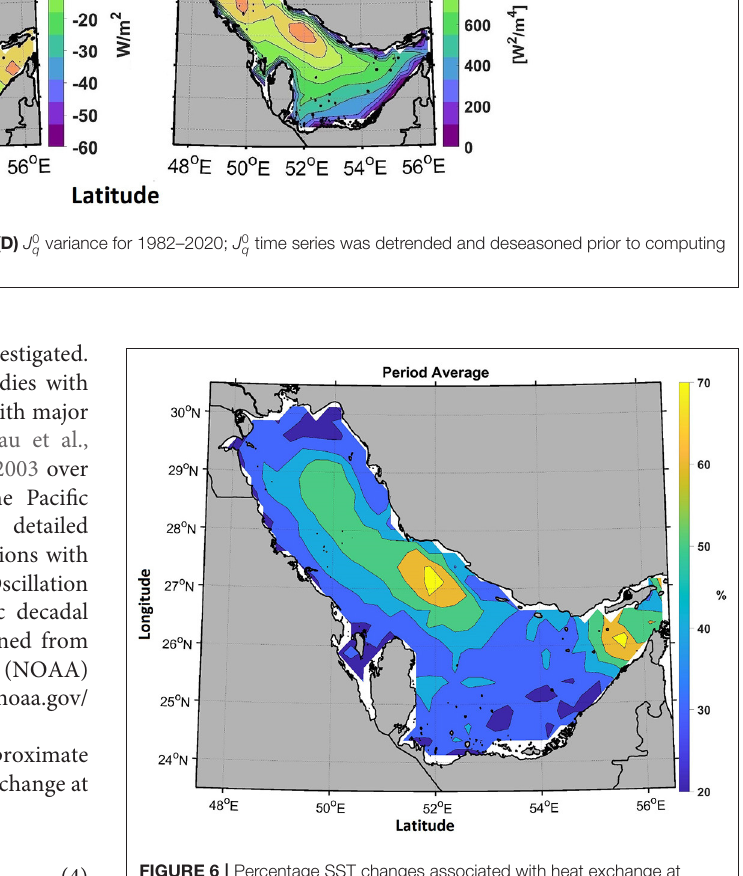
spatial resolution of 31 km. The ERA5 dataset is freely available